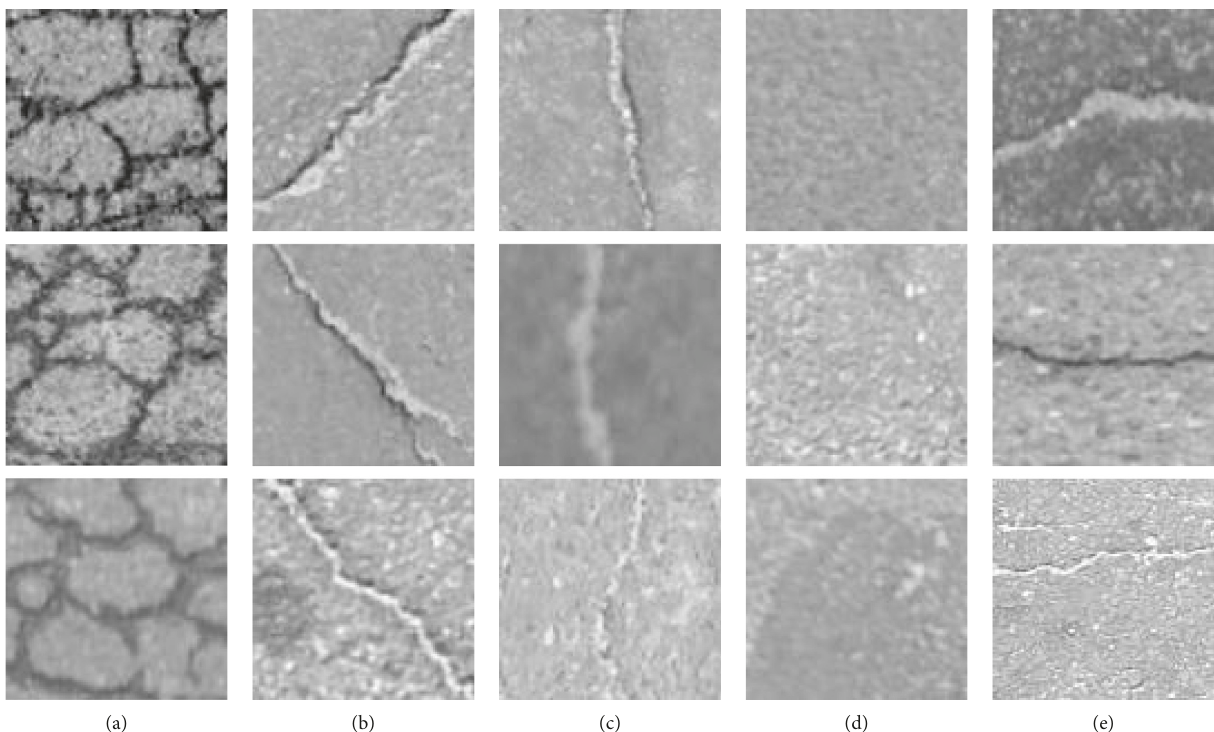
Figure 7: The collected dataset of pavement images. (a) AC, (b) DC, (c) LC, (d) NC, and (e) TC.